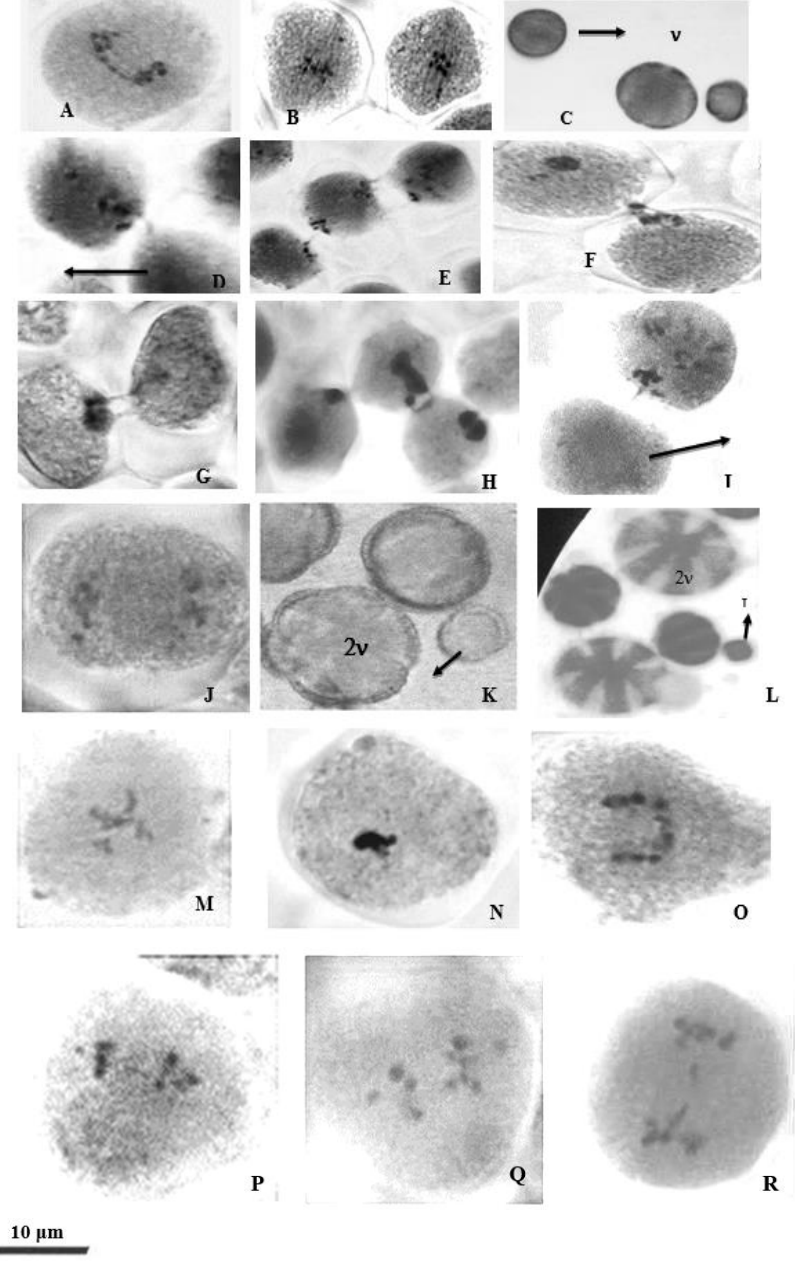
Figure 1: Stages of meiosis (A-C), cytomixis (D-L) and other related phenomena (M-R)